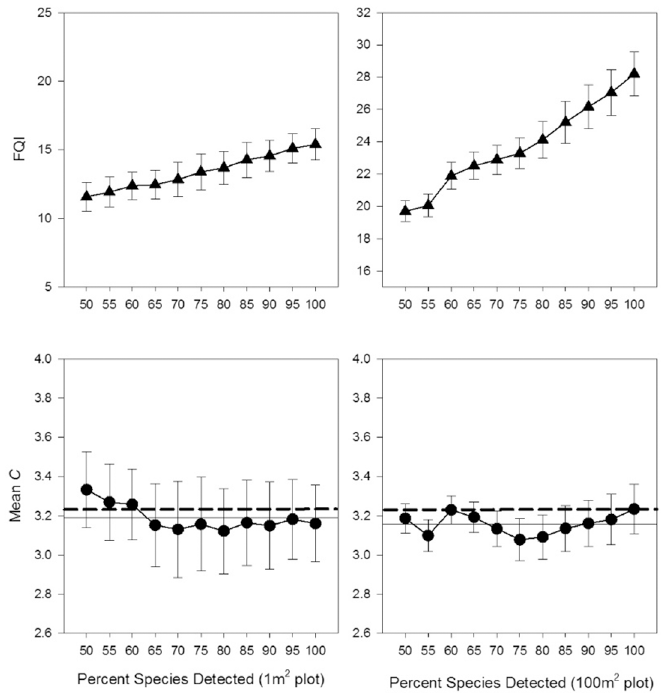
Fig 2. Average FQA values based on 100% – 50% of a plot ’ s potential species detected ( ± 95% CI; N = 20). Horizontal lines provide reference levels for comparison. Solid horizontal line indicates average of Mean C points for that plot ’ s size (50 ... 100%), and dashed horizontal line is 100% detection value in the 100-m 2